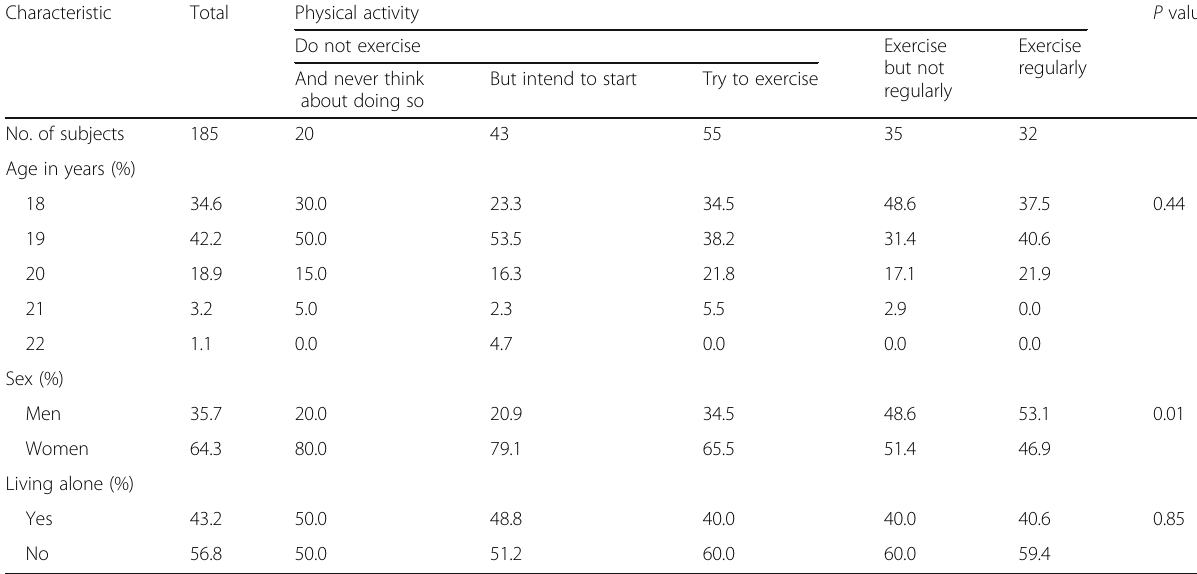
Table 1 Characteristics according to physical activity Characteristic